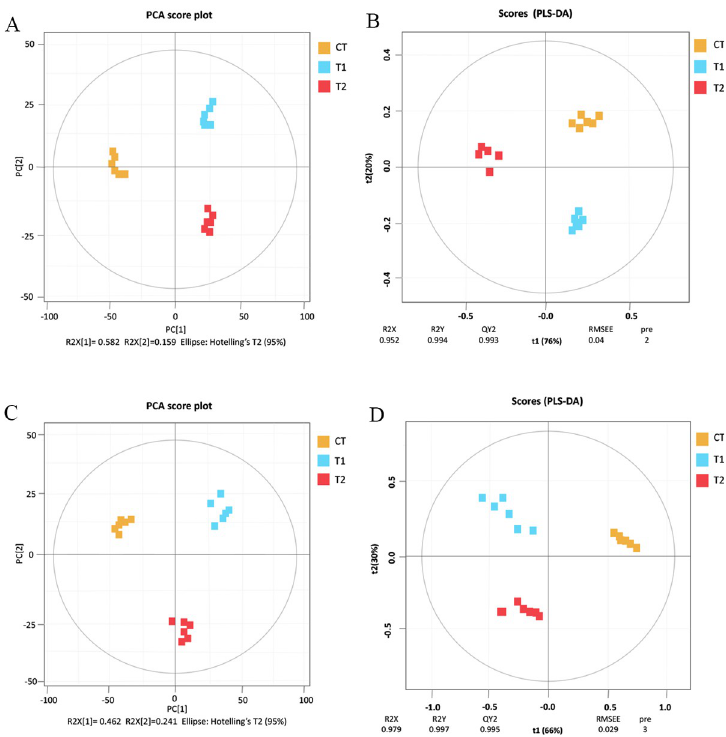
Fig 4. Metabolome of food waste fermentation products through PCA and PLS-DA. PCA (A) and PLS-DA (B) of the LC-MS compound metabolic spectrum to obtain the dispersion point diagram; PCA (C) and PLS-DA (D) of the GC-MS compound metabolic spectrum to obtain the dispersion point